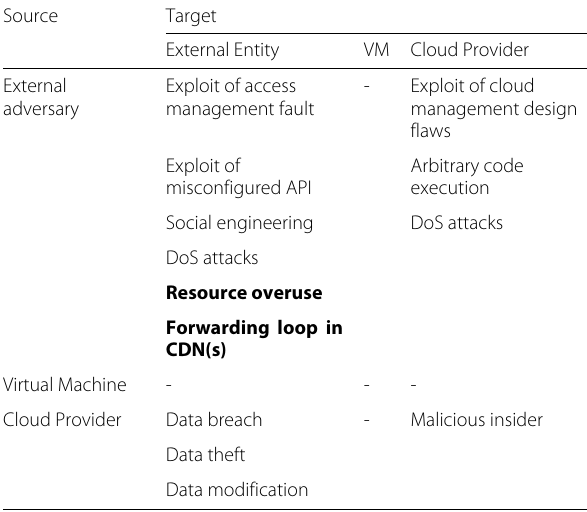
Table 1 Class 1: Attacks taking place outside of VMs, entries in bold require the adversary to be a registered cloud customer